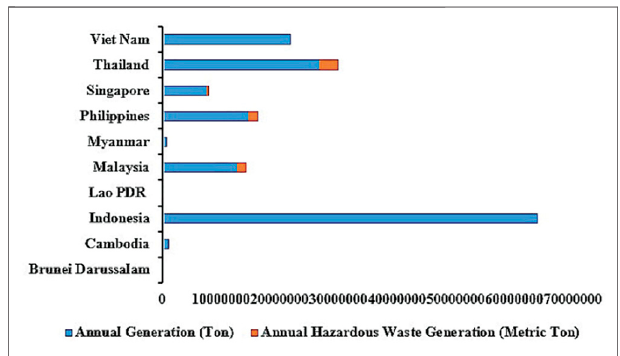
FIGURE 2 | The annual generation of materials waste, and hazardous waste of some ASEAN countries based on the fourth ASEAN State of Environment Report 2009.